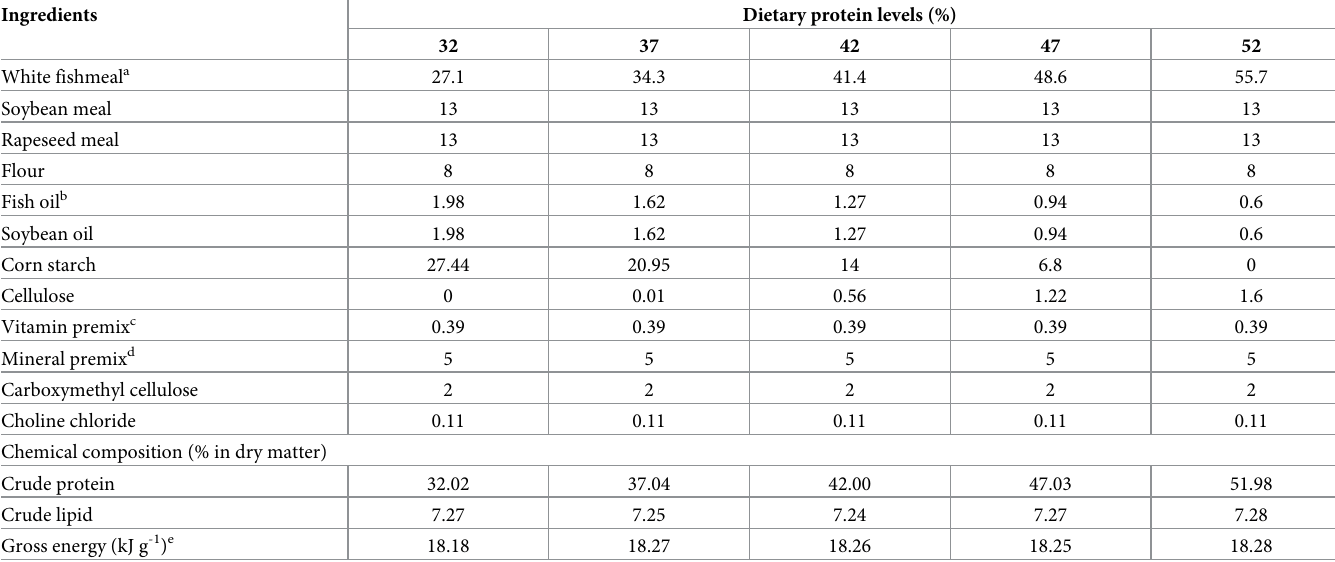
Table 1. Formulation and chemical composition of the experimental diets (% in dry matter